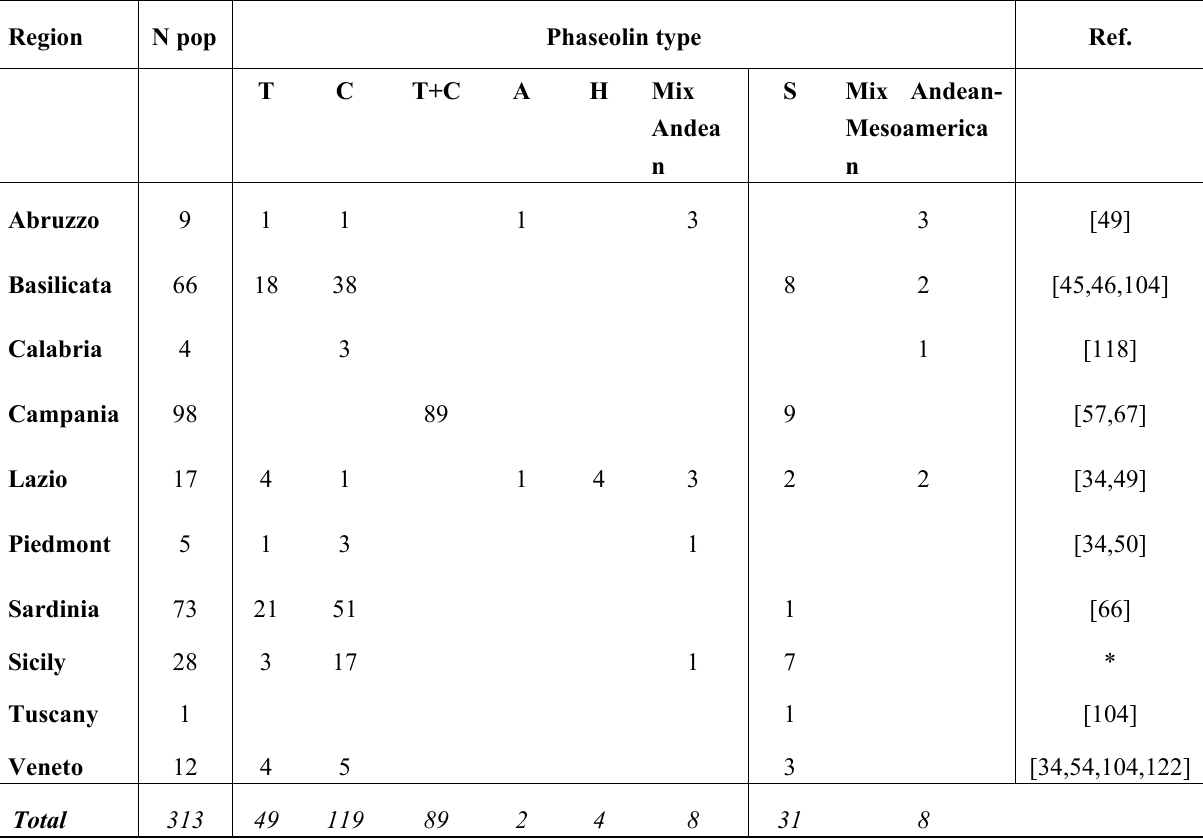
Table 3. Distribution of the phaseolin pattern frequencies within Italian common bean landraces as described in the